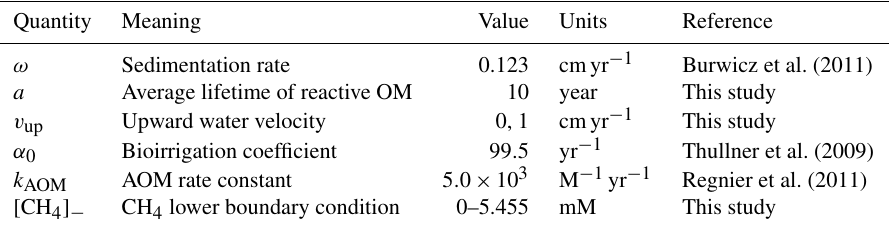
Table 1. Model parameters changed in the “one-at-time” sensitivity studies. Reported values are for the baseline simulations. Quantity Meaning Value Units Reference ω Sedimentation rate 0.123 cmyr − 1 Burwicz et al. (2011) a Average lifetime of reactive OM 10 year This study v up Upward water velocity 0, 1 cmyr − 1 This study α 0 Bioirrigation coefficient 99 . 5 yr − 1 Thullner et al. (2009) k AOM AOM rate constant 5 . 0 × 10 3 CH 4 lower boundary